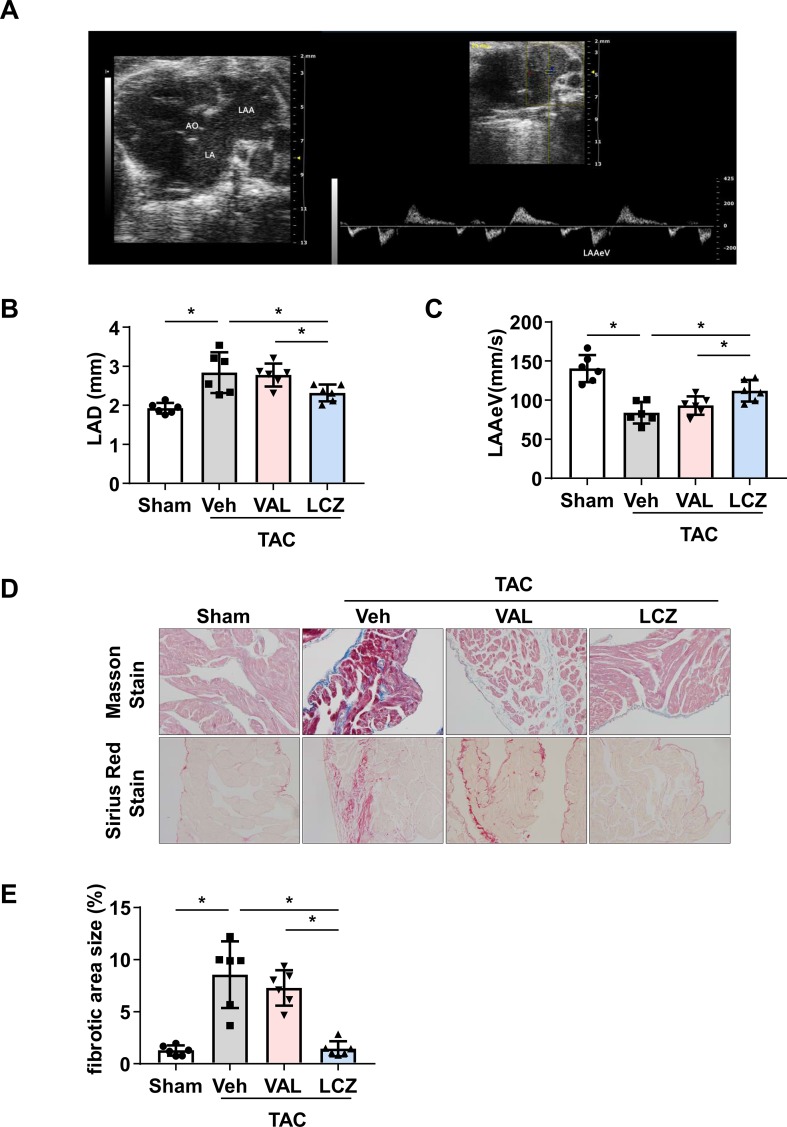
Sacubitril/valsartan is more effective than valsartan for protecting left atrial (LA) and left atrial appendage (LAA) function and decreasing LA fibrosis in mice after pressure overload.(A) 2D echocardiography showing LA, LAA, aorta (AO), and LAA emptying flow velocity (LAAeV) from the basal short-axis view. (B, C) Left atrial dimension (LAD) and LAAeV quantified by echocardiography. (D) Representative images of Masson staining and Sirius Red staining of LA. Scale bar, 100 μm. (E) Quantification of the fibrotic area in (D). TAC, transverse aortic constriction; Veh, vehicle; VAL, valsartan; LCZ, LCZ696. Data are mean ± SEM, n = 6 mice per group, *P < 0.05, one-way ANOVA.